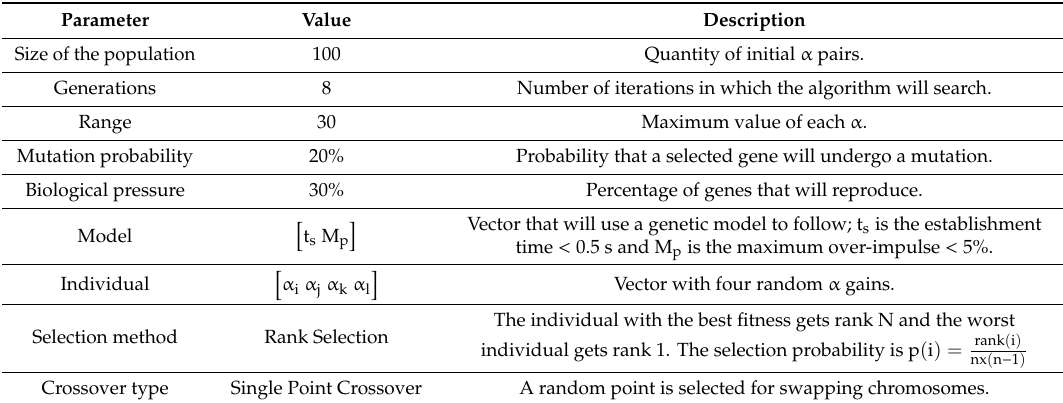
Table 1. Parameters of the genetic algorithm.